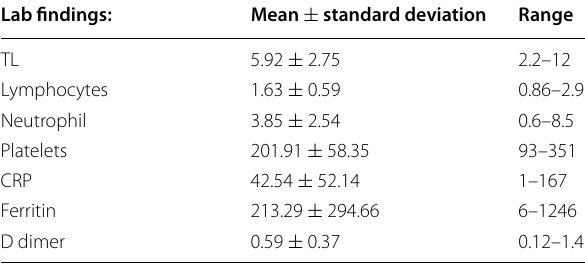
Table 1 Characteristics and clinical presentation of COVID-19- Table 2 Laboratory findings of COVID-19-infected PH cases